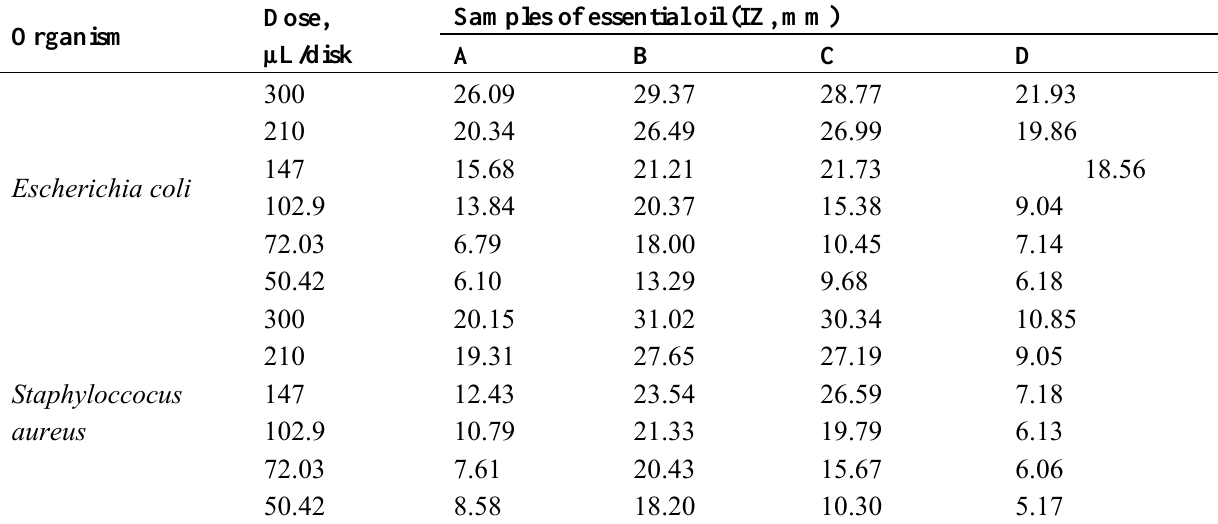
Table 3. Antimicrobial activity of the essential oils of the four samples given as inhibition zone (measured in mm) a